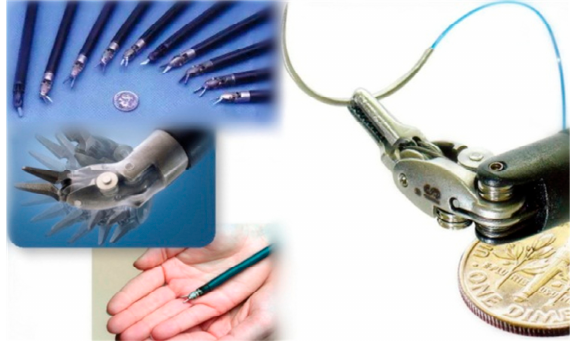
Figure 1. Some surgical robot instruments.